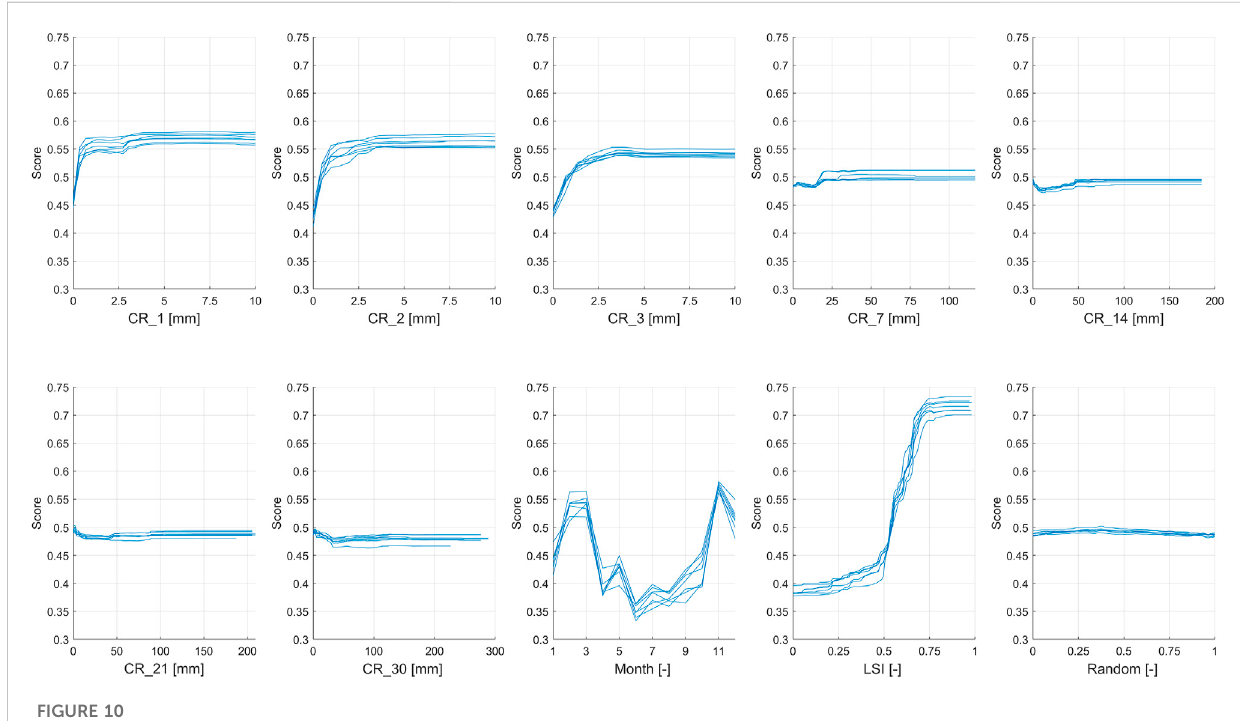
FIGURE 10 PDP for the third test and the fi rst con fi guration.